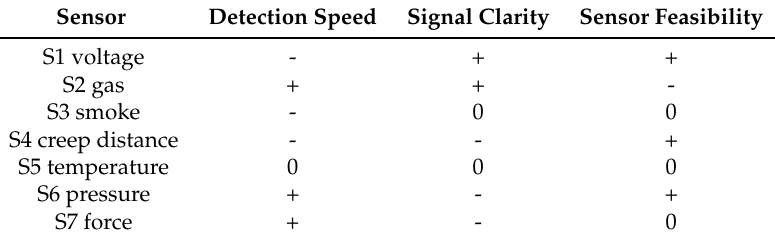
Table 3. Evaluation of the different sensors on three categories. Signal clarity describes how close the detection signal comes to a step function and how easy it is to evaluate it, whereas sensor feasibility evaluates how easy the sensor can be deployed. Grading goes from (+) good, to (0) neutral to (-)